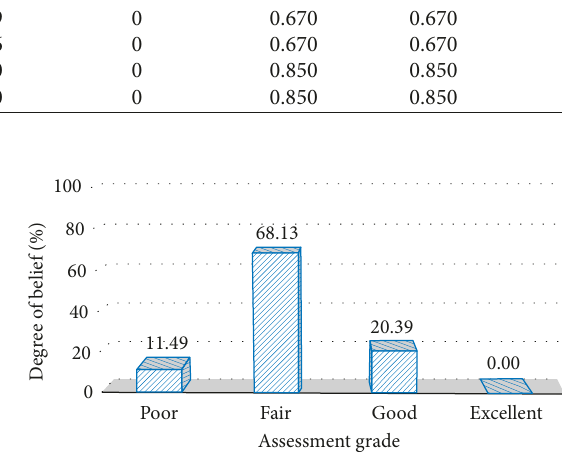
Figure 4: Overall condition assessment of the substructure bridge component.